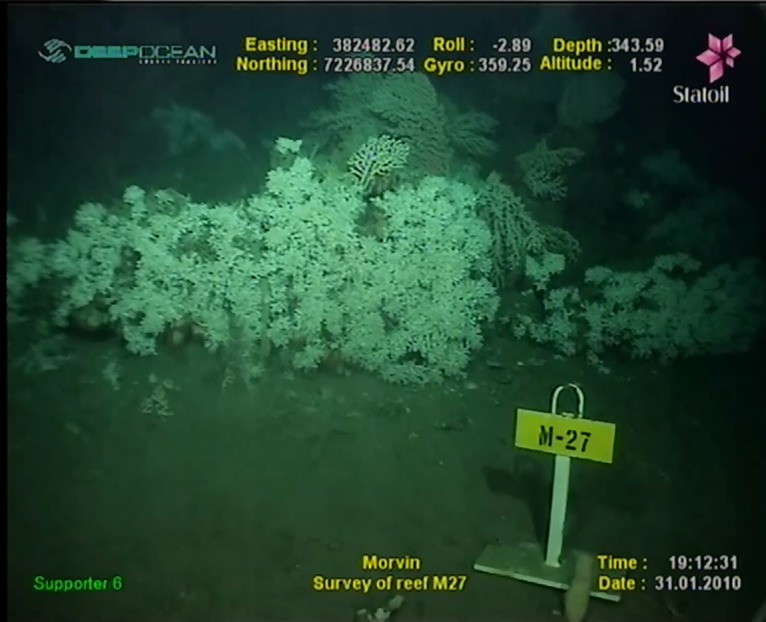
Typical reef marker.All reefs were marked with comparable markers, this is the marker positioned at reef M27.